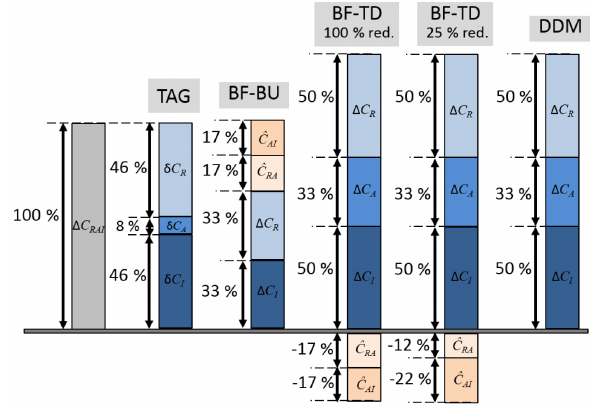
Figure 2. Schematic representation of the allocation of PM to its sources in the non-limited example. The expected total PM is dis- played in the grey bar on the